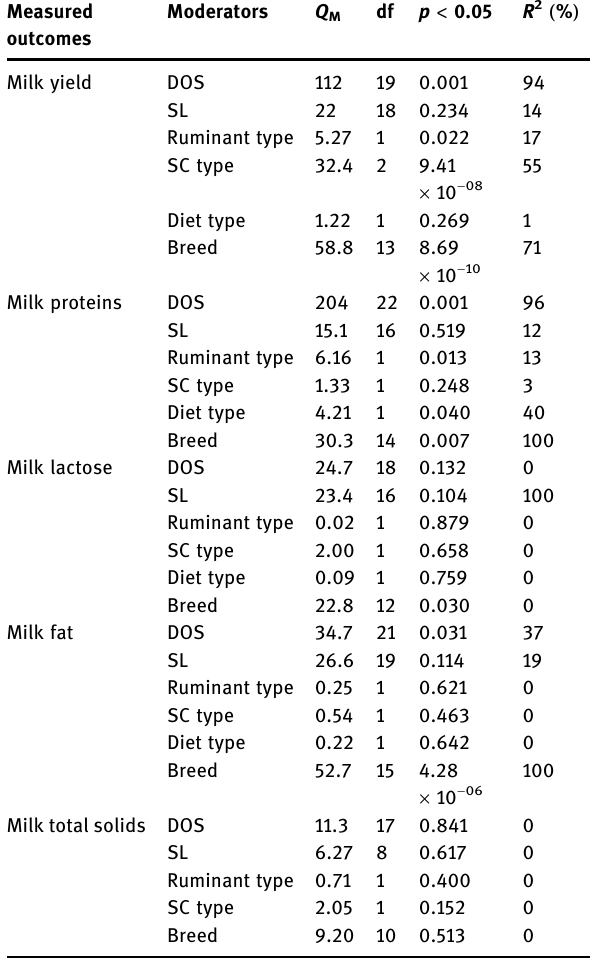
Table 5: Relationship between moderators and milk production variables in lactating small ruminant Measured